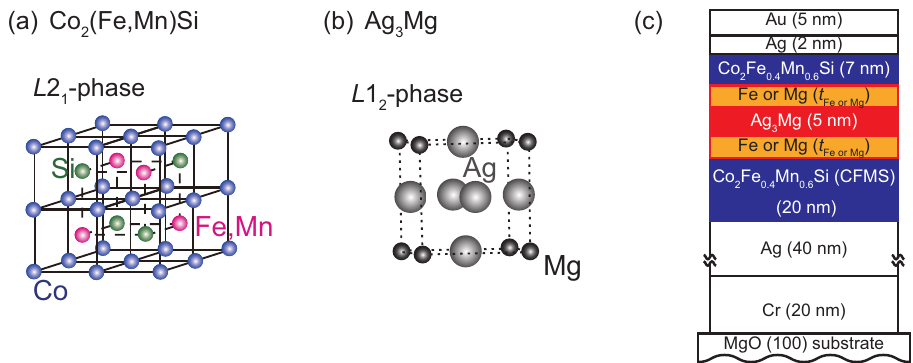
Figure 1. Schematic illustrations of crystal structures for ( a ) Co 2 (Fe,Mn)Si (CFMS) full Heusler alloy in the L 2 1 phase; ( b ) Ag 3 Mg alloy in the L 1 2 phase, and ( c ) stacking structure of the layered films for current perpendiculr to plane (CPP) giant magnetoresistance (GMR)